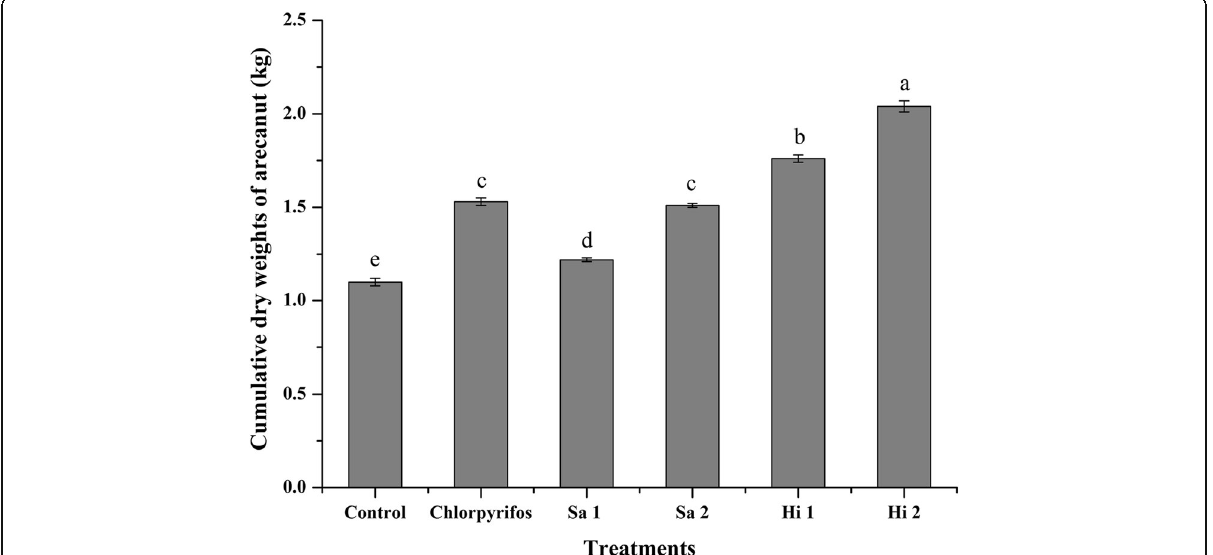
Fig. 2 Cumulative kernel weights of areca nut palms treated with different treatments in North Canara district, Karnataka, India, during 2015 – 2017. Different letters on the top of error bars indicate statistically different values for different nematode concentrations using Tukey ’ s test ( P <0.05). Bars=standard error Sa, Steinernema abbasi ; Hi, Heterorhabditis indica ; 1 = 1.7×10 5 IJs palm − 1 , 2 = 3.5×10 5 IJs palm − 1 . Chlorpyrifos was used at the rate of 6 ml palm − 1 as a drench